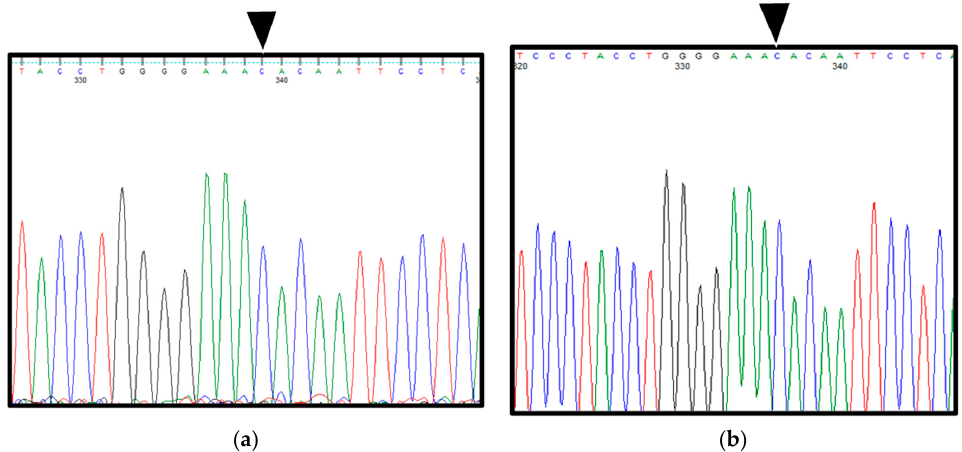
Figure 5. Analysis of the sequence of the entire Gli1 gene in the patient’s excised samples and blood based on Sanger sequencing. ( A ) DNA sequencing of blood in patient 1. ( B ) DNA sequencing in excised specimens in patient 1 (synovial tissue). Black arrows indicate a point mutation site from G to C in exon 12 of Gli1 .